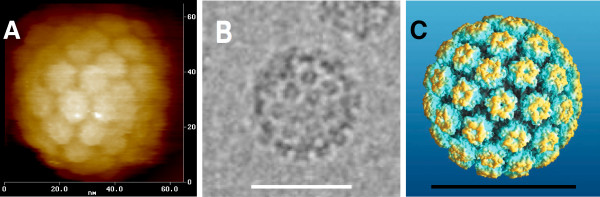
HPV16 VLP dimensions and morphology. (A) Atomic force microscopy image of a post-D/R HPV16 VLP, adapted from [16]. (B) CryoEM image of a post-D/R HPV16 VLP. The scale bar is 50 nm long. (C) Atomic model of the T = 7 HPV16 VLP. The scale bar is 50 nm long. The model was generated as described in the Methods.